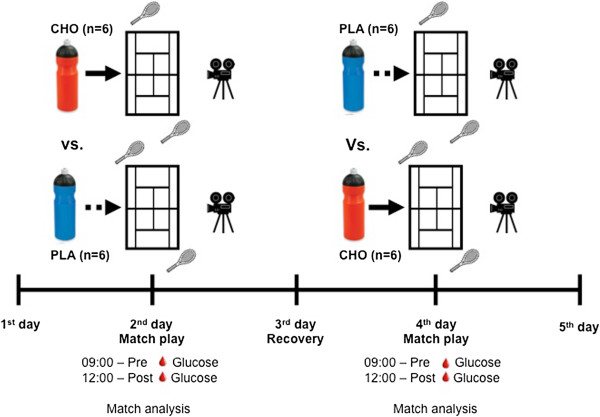
Experimental design.